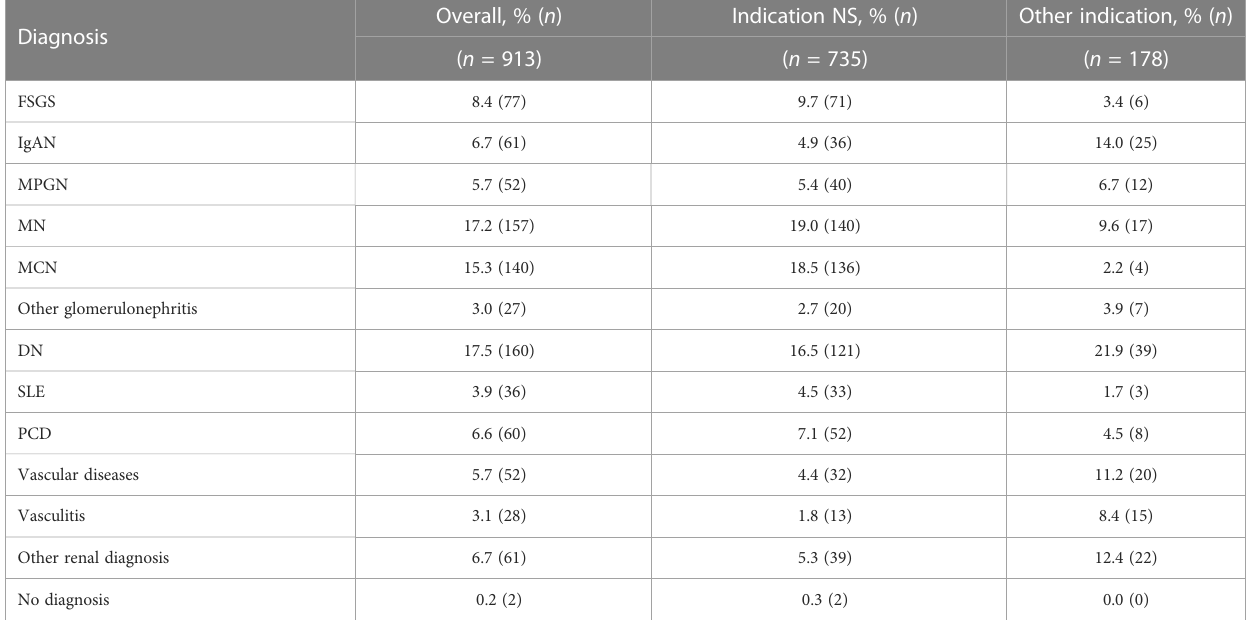
TABLE 3 Causes of NS depending on indication for